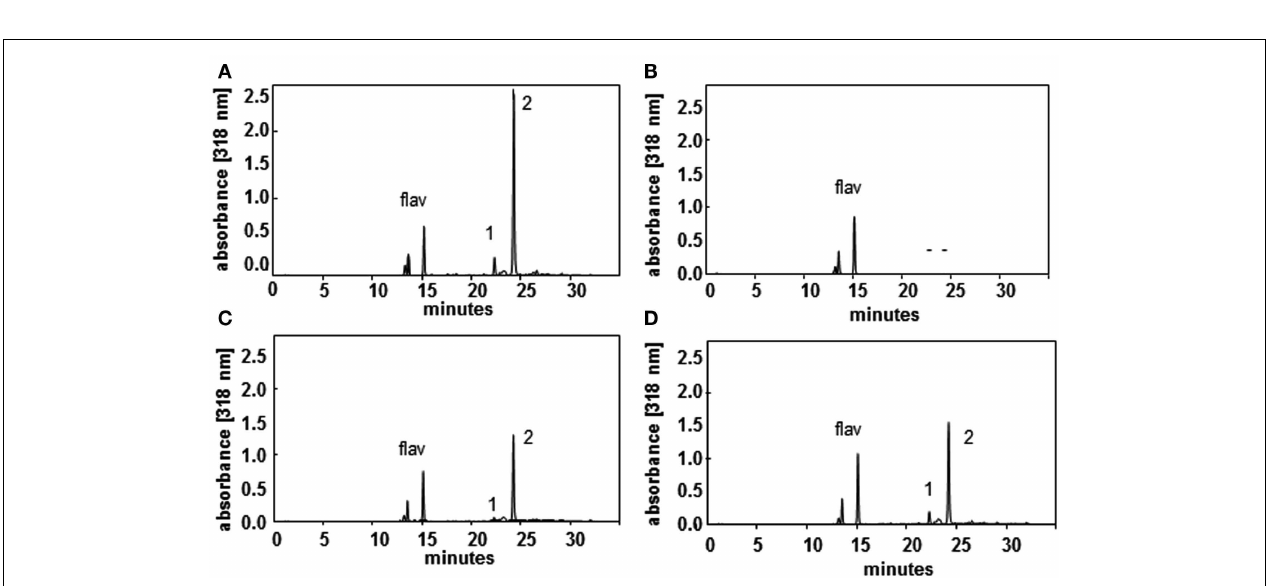
FIGURE 4 | PA content of various organs in A. thaliana . Mature rosette leaves, stems, flower buds, and siliques were harvested from 6-weeks-old plants and the PA content was analyzed. Mean values and ± standard deviations ( n = 3) are shown.